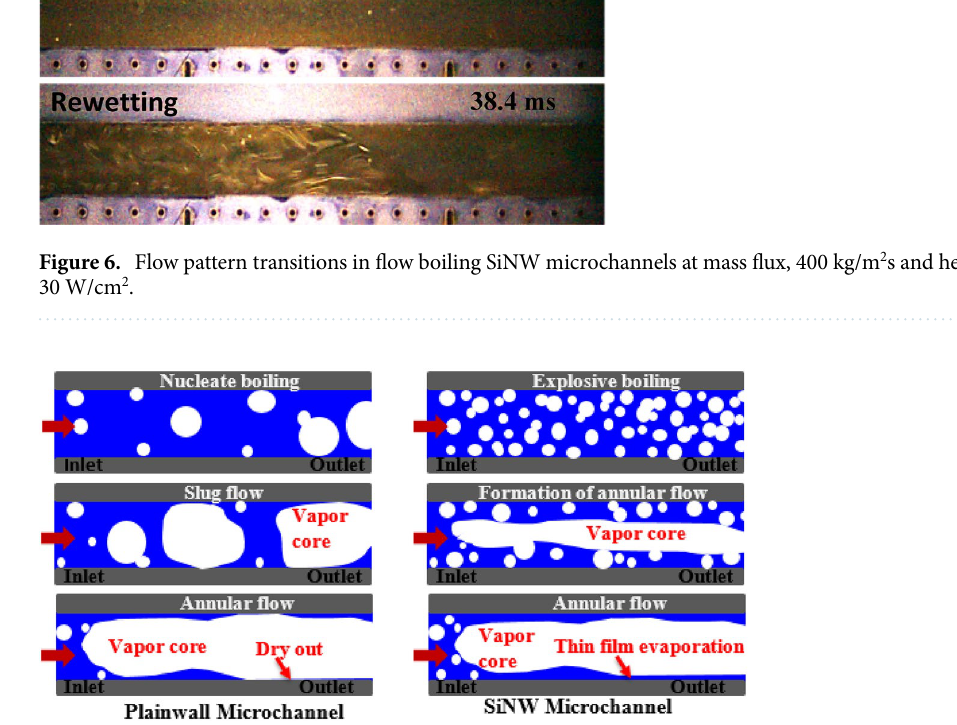
Figure 7. Typical flow pattern transitions of flow boiling in plainwall microchannels and SiNW